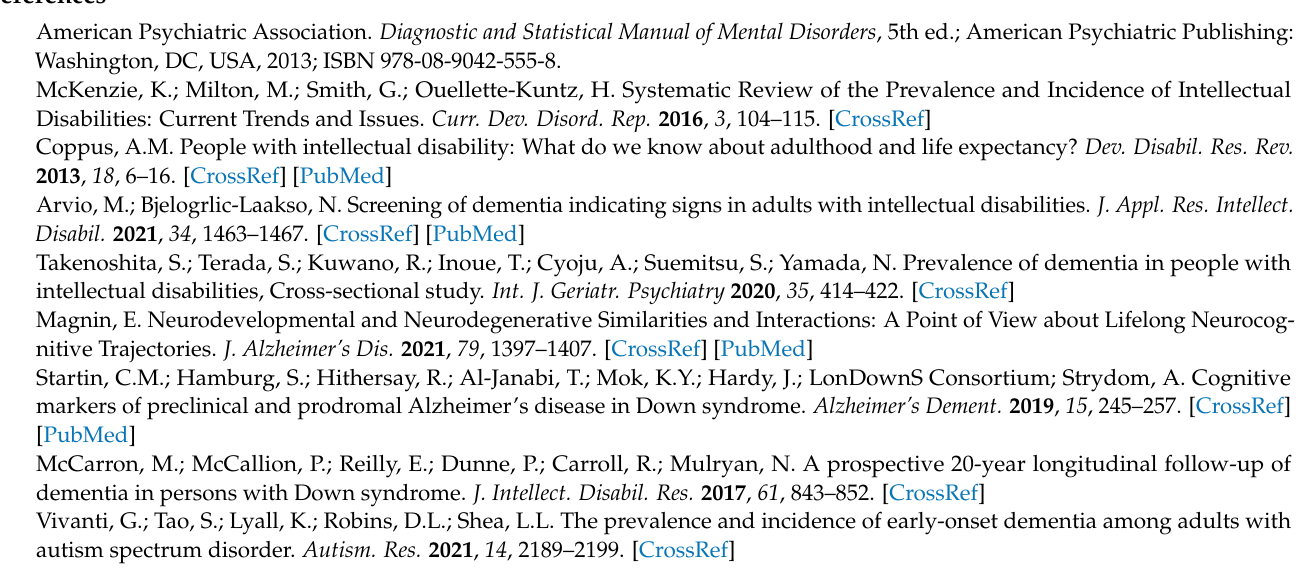
Table S3: Normative data of the PMIS-ID total score for different cut-off points for AD in moderate level of ID sample; Table S4: Normative data of the PMIS-ID immediate total score for different cut-off points for AD in mild level of ID sample; Table S5: Normative data of the PMIS-ID delayed total score for different cut-off points for AD in mild level of ID sample; Table S6: Normative data of the PMIS-ID total score for different cut-off points for AD in mild level of ID